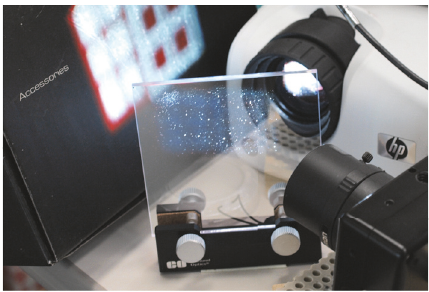
Figure 5: Our prototyping experiment regarding pro-cam coaxial- ization with a plate beamsplitter. In this experiment, both projector and camera are operating in the same visible light spectrum. The projector is projecting an image of red and white square